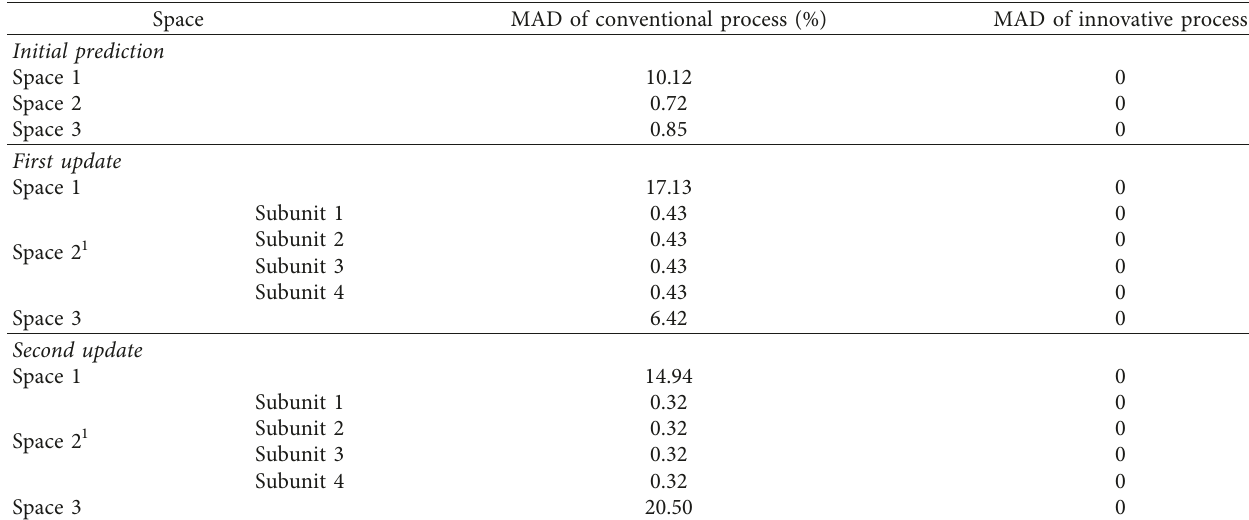
Table 7: MADs of the three Case 3